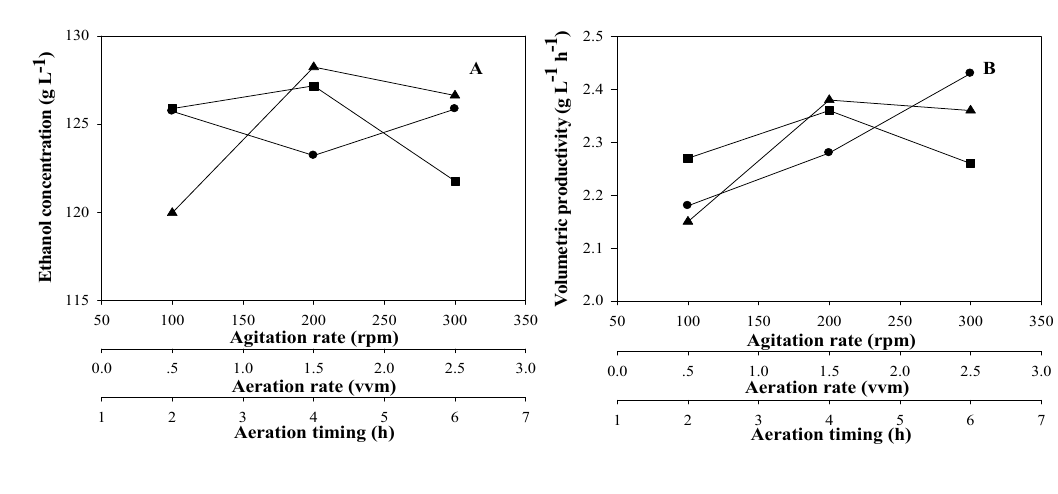
Figure 4. The ethanol concentration ( A ) and productivity ( B ) at different levels and factors ( ▲ = agitation rate, ● = aeration rate and (cid:132) = aeration timing)